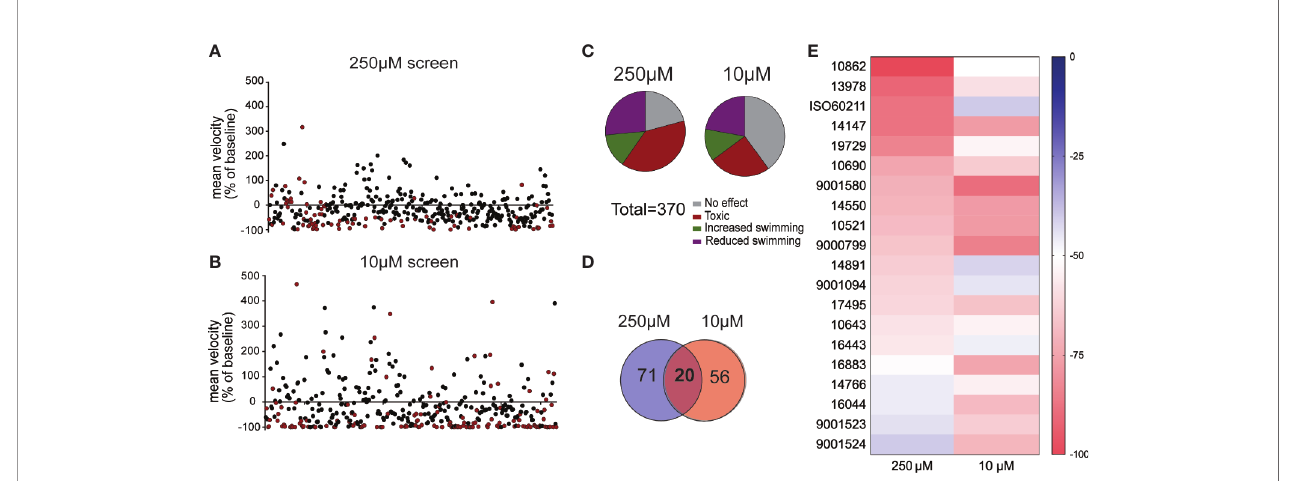
FIGURE 1 | A library of synthetic cannabinoids (SCs) was screened for their ability to reduce the high velocity seizure-like swim behavior of 5 day old zebra fi sh larvae. Compounds were screened at (A) 250 µM and (B) 10 µM. Each data point represents the mean velocity change in swim behavior of six fi sh treated with an individual compound. The red data points represent compounds that failed to go into solution or identi fi ed as toxic after 90-min exposure. (C) Summary of compound effects after screening 370 SCs at 250 and 10 µM. The threshold for inhibition of seizure activity was determined as a reduction in mean swim velocity of ≥ 40%. (D) The total number of compounds identi fi ed as positive from the 250 and 10 µM library screen. (E) Heat map representing the 20 compounds which successfully reduced the mean swim velocity by >40% in the 250 and 10 µM